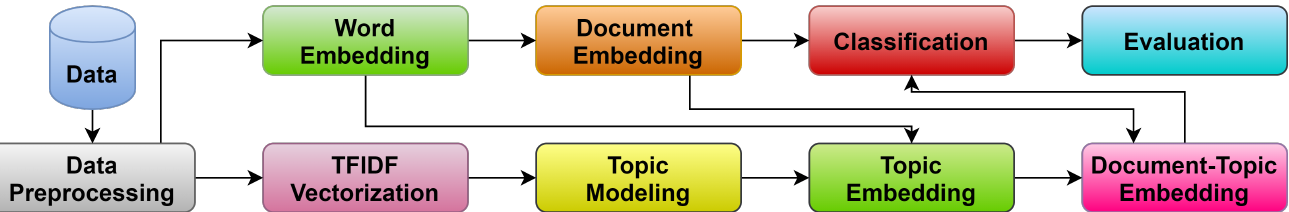
Figure 1. The proposed topic-based Sentiment Analysis using a contextual cues